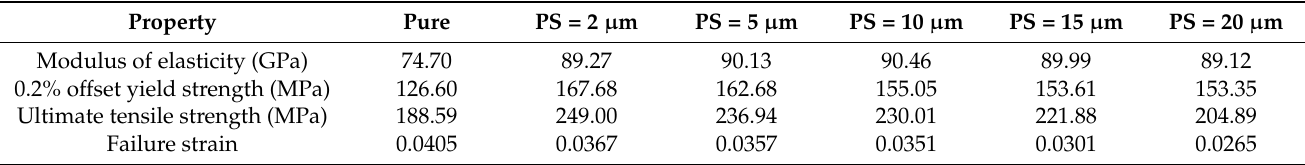
Figure 13. Effect of SiC particle size on the true stress–strain curve of A359/SiC composite (10% VF). Table 3. Effect of the SiC particle size on the mechanical properties of A359/SiC composite (10% VF).